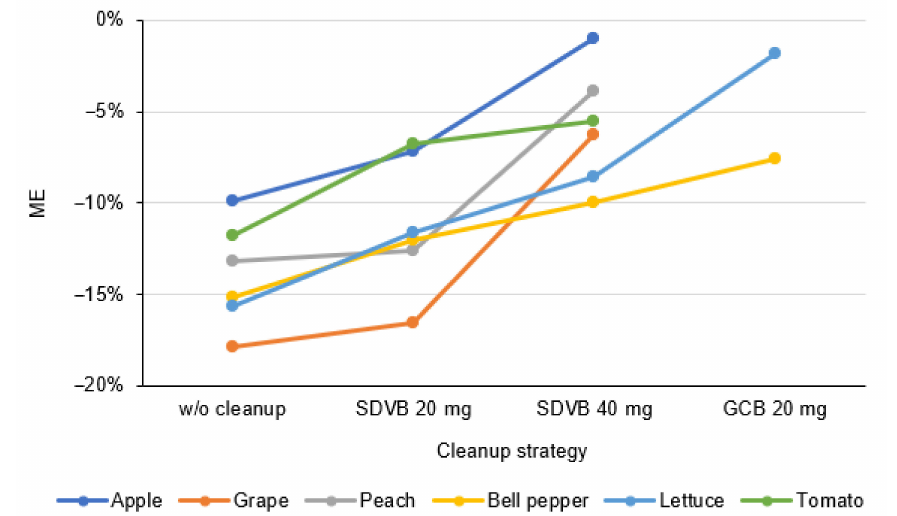
Figure 4. Effects of different cleanup strategies on the ME of fruit and vegetable samples.